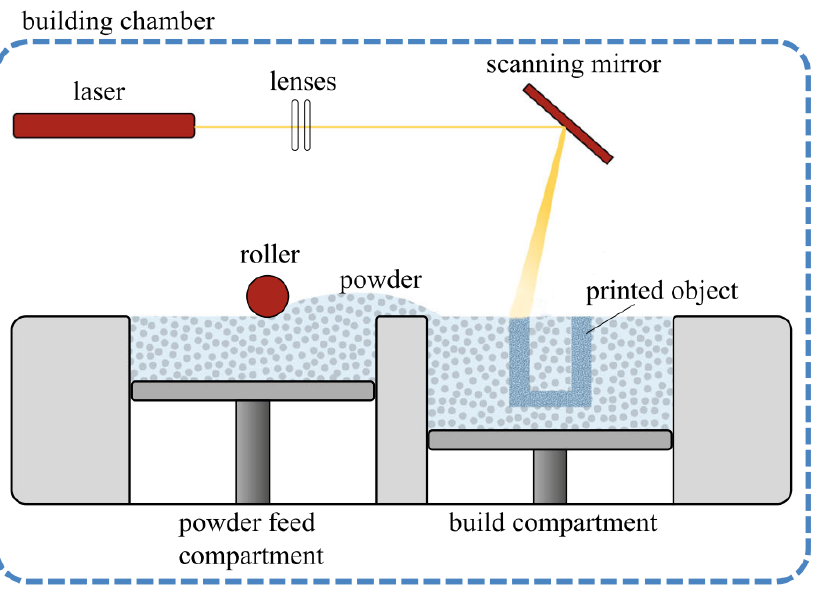
Figure 2. Schematic depiction of the laser sintering process inside the building chamber of the 3D printer. Here, the powder feed compartment holds the polymeric powder, and the build compartment is where the deposition of a new layer of powder and the laser scanning and sintering of a new layer of the printed object takes place. The laser passes through a convex lens onto a scanning mirror, which can rotate to move the laser spot along the surface of the deposited layer. Reproduced with permission [19], Copyright 2020, Springer